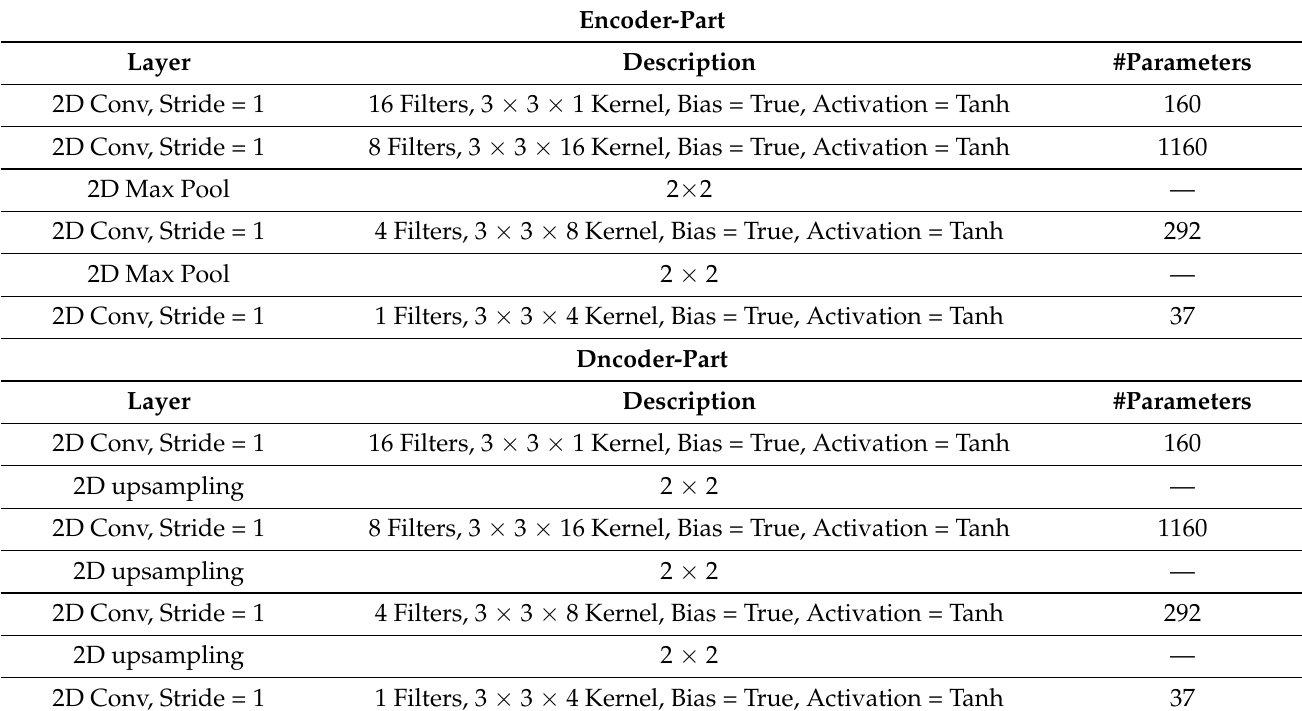
Table A3. Parameters of the Image Compression